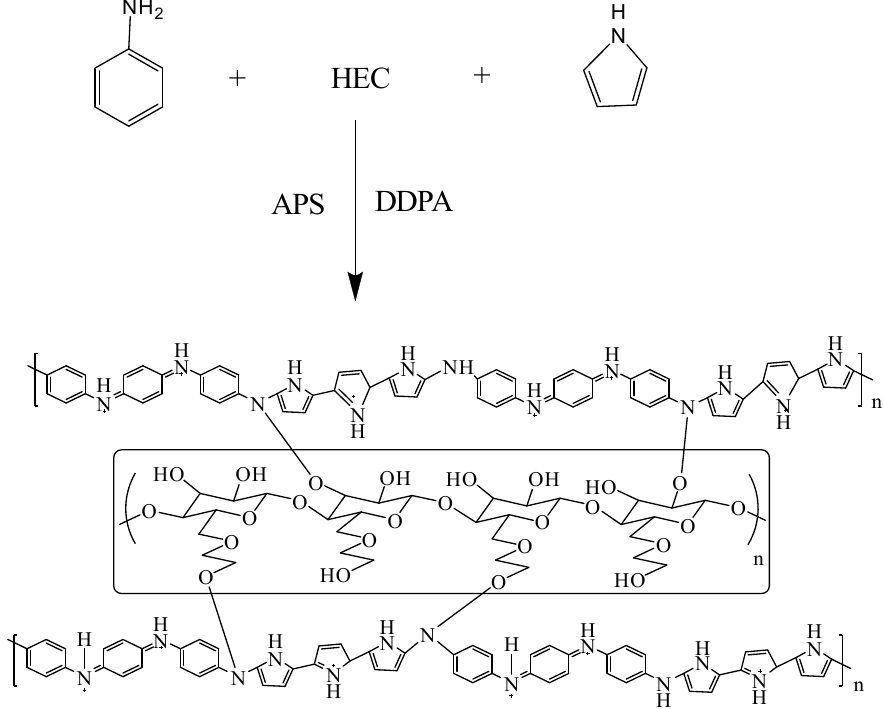
Figure 2. View of chemical polymerization of PANI and PPy on HEC.